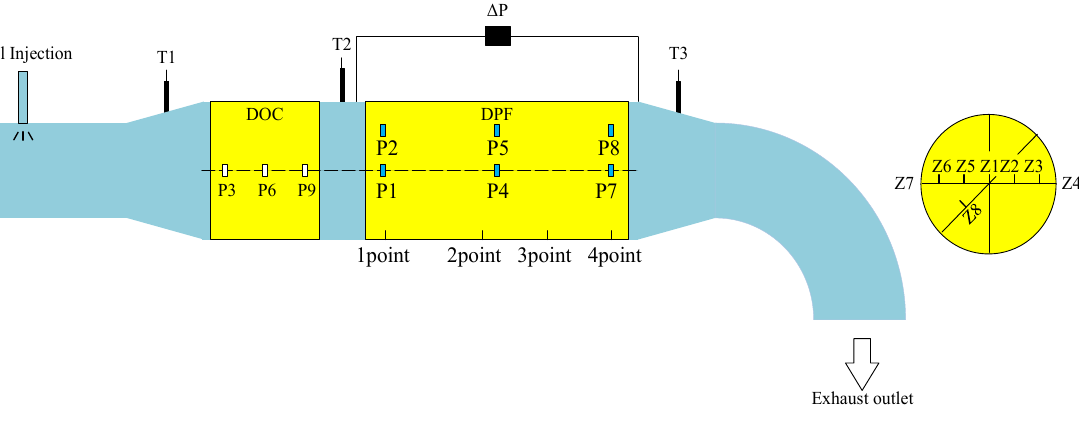
Figure 2. Temperature sampling points in DOC and DPF. Armored thermocouple-type temperature sensors with a 1-mm probe diameter are arranged inside the DOC and DPF to axially measure the temperature of the DOC’s center and the temperature field variation regularly inside the DPF during the thermal regeneration. The distribution of the thermocouple probes inside the DOC and DPF is shown in Figure 2, and the measurement temperature ranges from 0 to 1200 ◦ C, with a measurement error within ± 0.4% and a thermal response time less than 0.2 s, which satisfies the measurement